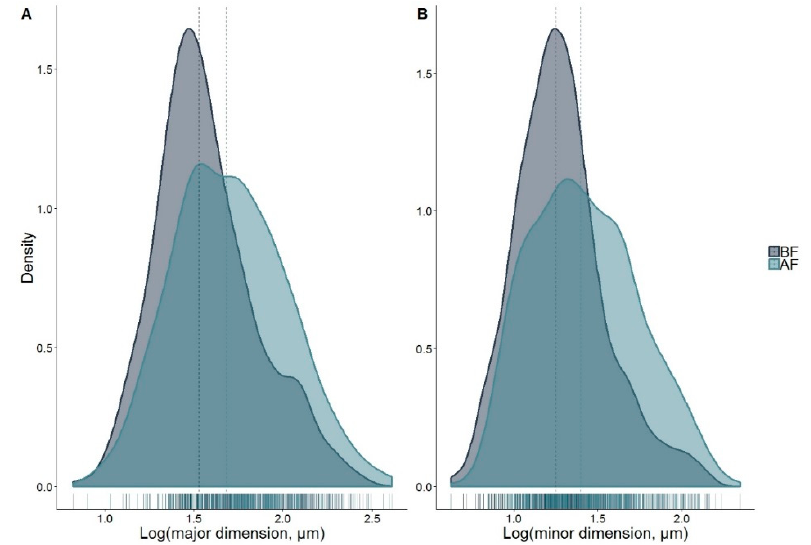
Figure 3. Frequency distribution of the size of MPs in wastewater before (BF, grey) and after (AF, light green) disc filter treatment, by the particles’ major ( A ) and minor dimension, ( B ) on a logarithmic scale. The dark green area indicates overlaps between BF and AF data. The dashed lines denote the median particle dimension. The rug on the x-axis illustrates the distribution of data points.